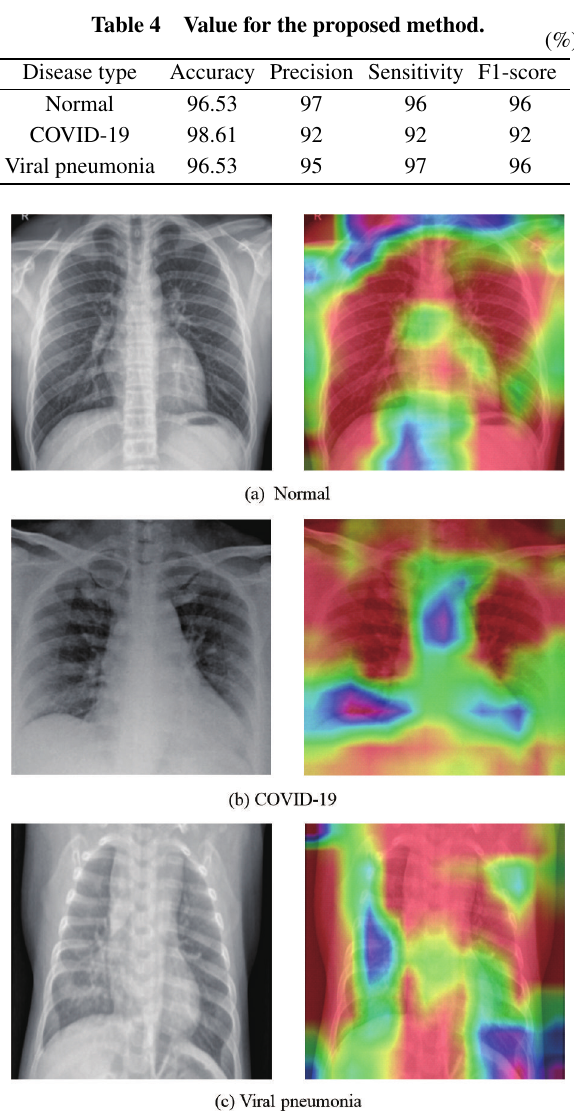
Fig. 4 Grad-CAM visualization of (a) normal, (b) COVID- 19, and (c) viral